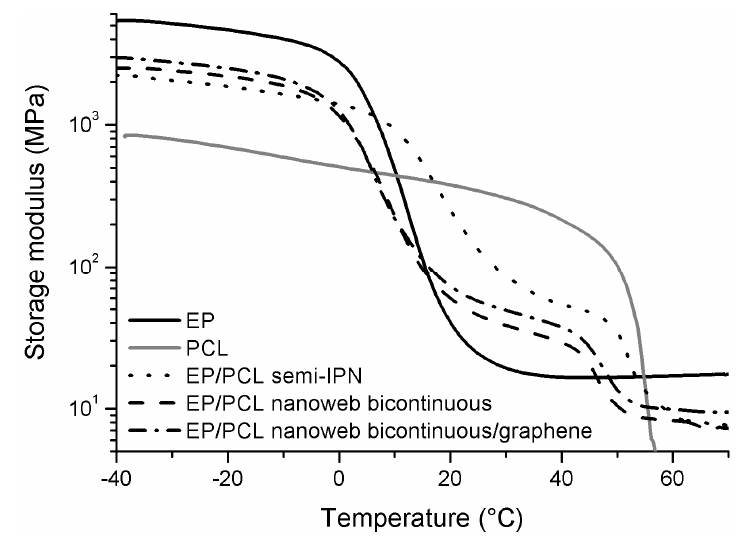
Figure 3. Storage modulus as a function of temperature for the EP/PCL with different structures and their plain constituents. Note: PCL content is 23 wt %.